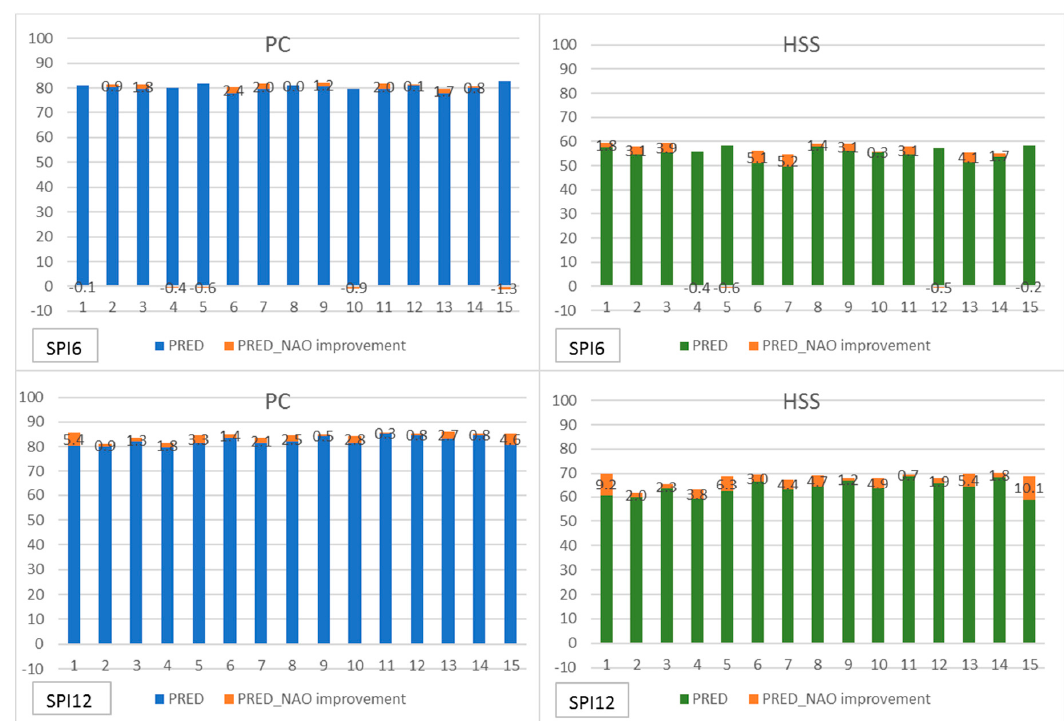
Figure 5. PC and HSS improvement (%) considering the influence of NAO on the SPEI6 and SPEI12 modeling for the extended winter months for each of the 15 grid points.